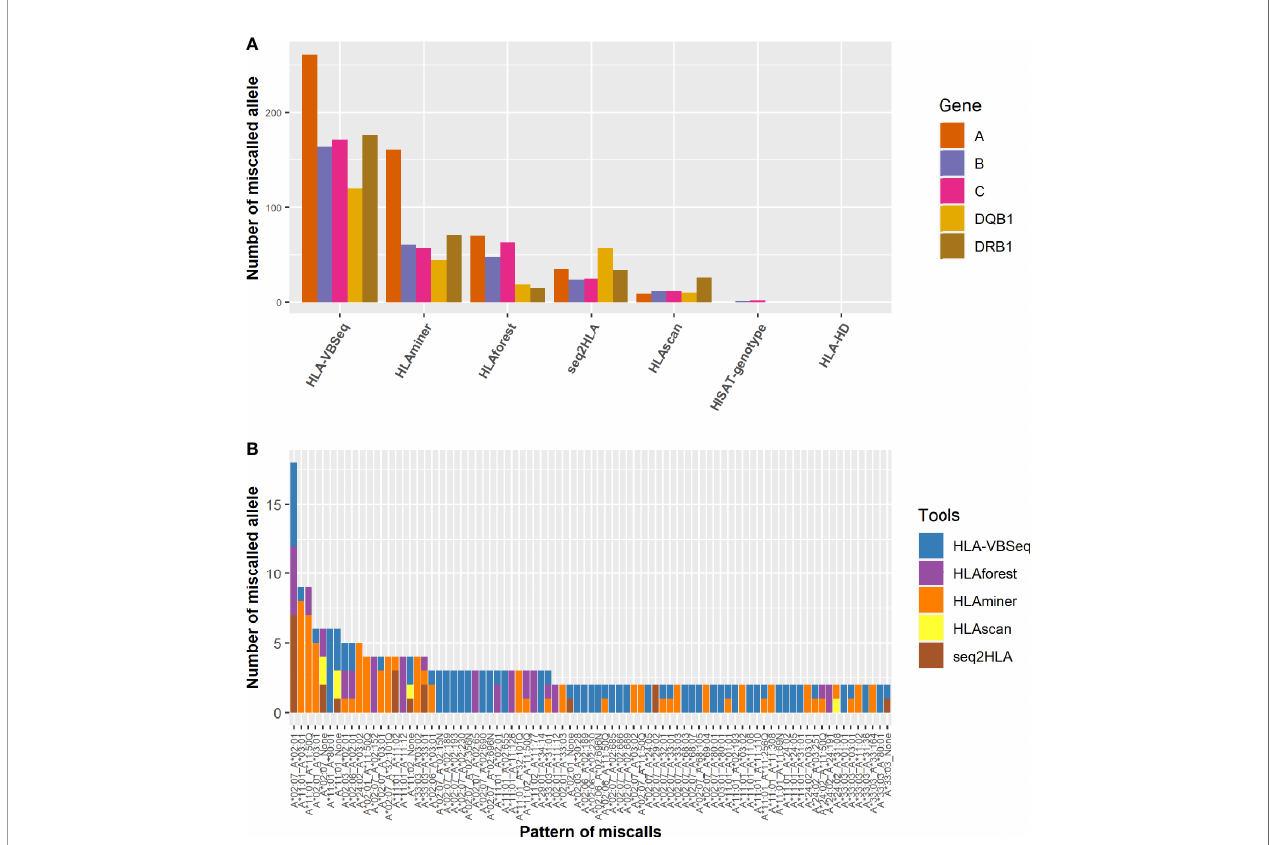
FIGURE 4 | Distribution of the pattern of genotyping errors in HLA-A genes. (A) The number of miscalled alleles by each algorithm grouped by the HLA genes. (B) The pattern of discordant HLA-A alleles at the second fi eld level. None, not determined by the